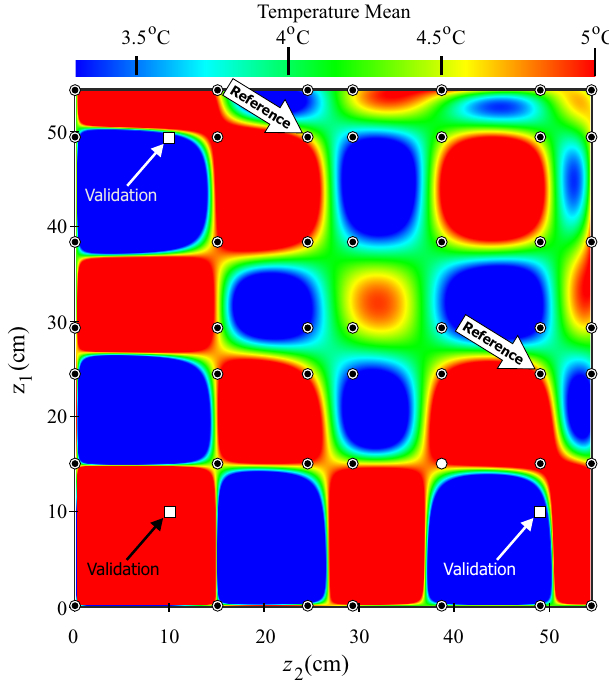
Figure 6. Thermal simulation using Lagrange’s